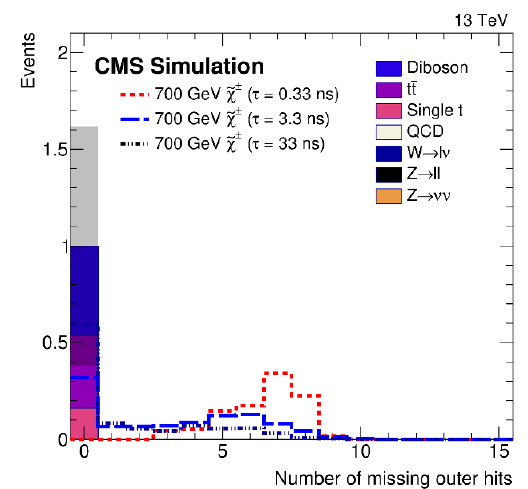
Figure 2 . Distributions of the number of missing outer hits for tracks in simulation that pass the full selection, except for the requirement on that variable. Each signal distribution and the sum of the SM background distributions are scaled to have unit area. The gray shaded area indicates the statistical uncertainty in the SM